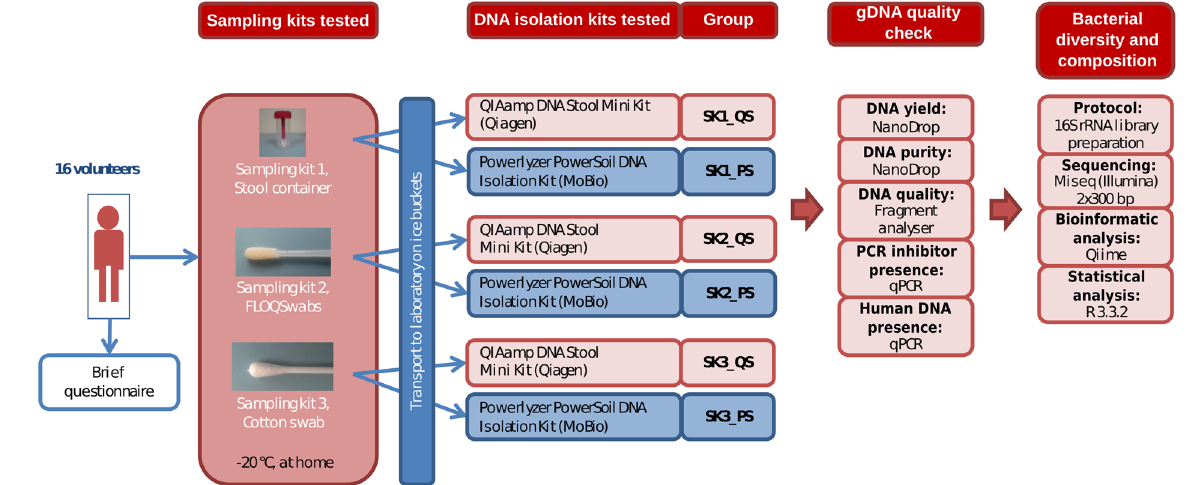
Figure 6. Study design. Flowchart summarizing the study design and methods used.